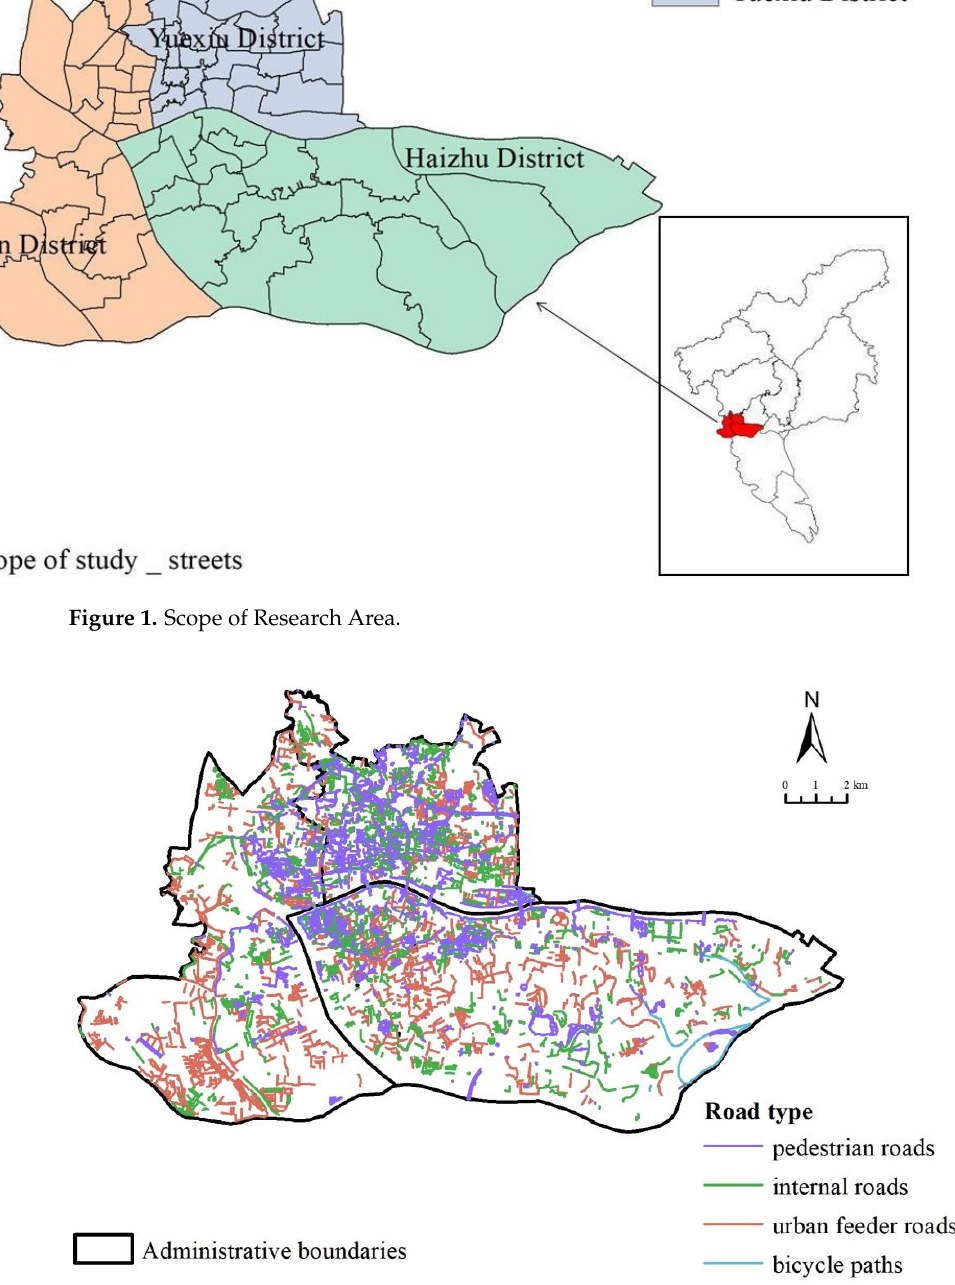
Figure 3. Spatial distribution of Sampling Points of Streetscape Images. 2.2.2. Streetscape Data The Streetscape data are mainly used for extracting Streetscape elements. Tradition- ally, first-hand data are obtained from photographic records and several methods are taken to standardize the photographs and minimize variation for quantitative research on